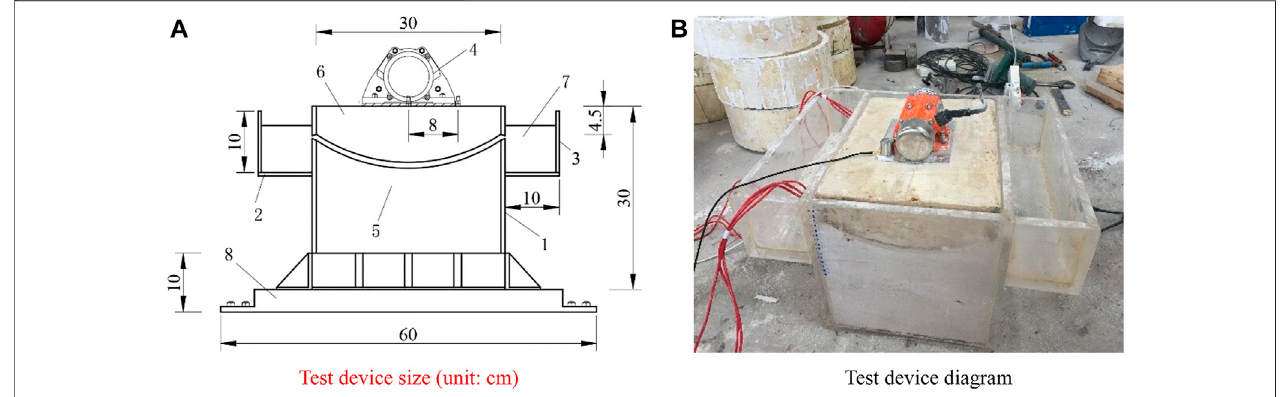
FIGURE 5 | Evacuation test device for tunnel basement structure. (A) Test device size (unit: cm). (B) Test device diagram.